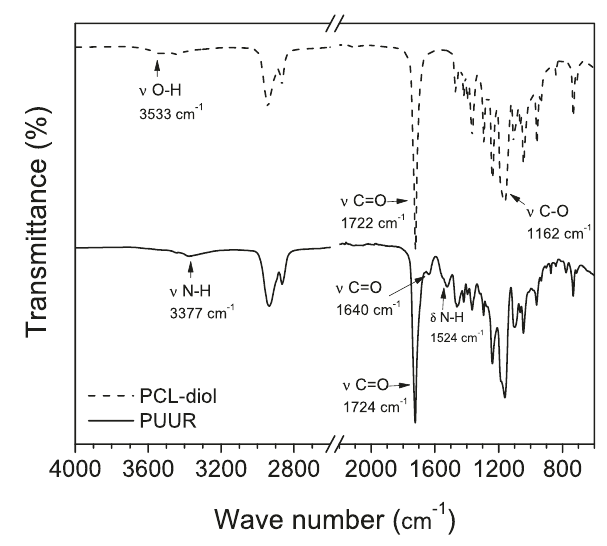
Fig. 1 FTIR spectra of PCL-diol and PUUR